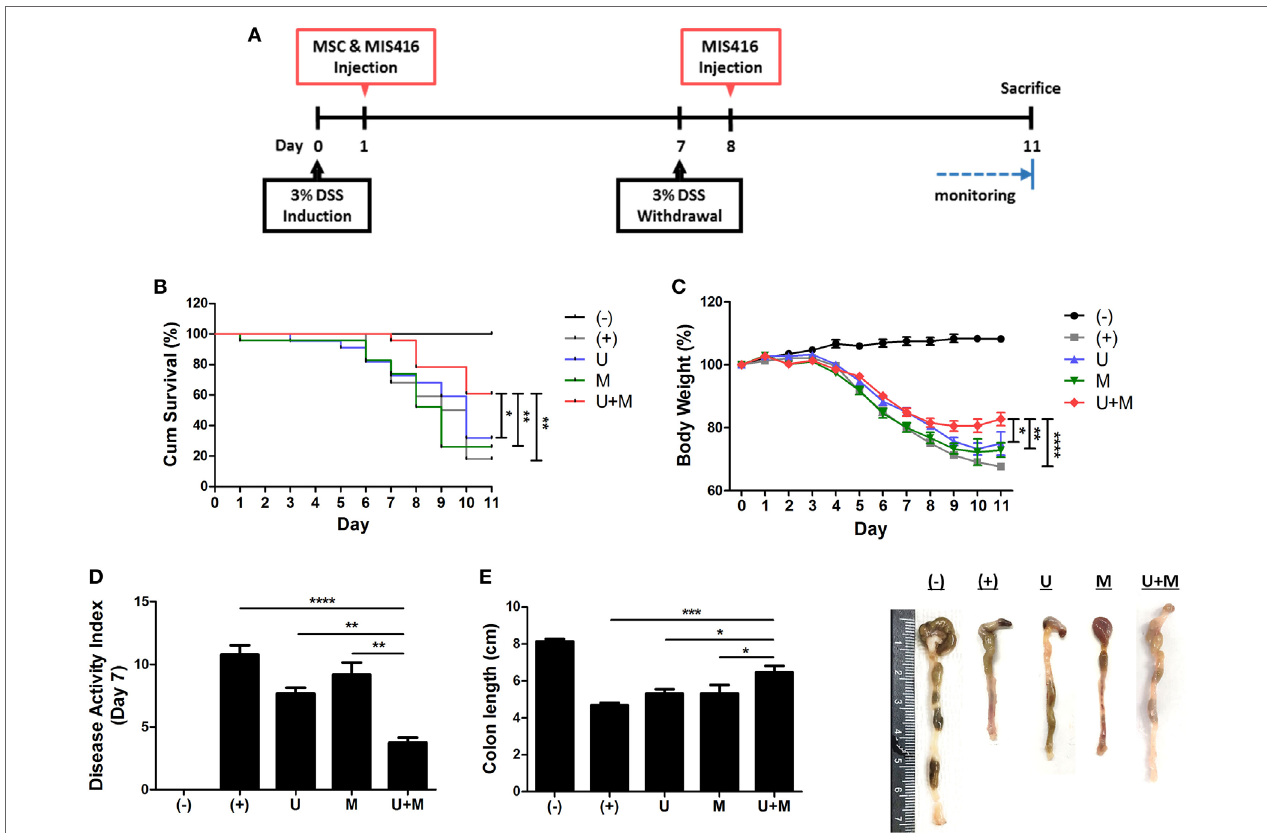
FigUre 1 | Simultaneous administration of MIS416 and human adult stem cells, including umbilical cord blood-derived mesenchymal stem cells (hUCB-MSCs) enhances therapeutic effects of the cells against experimental colitis. Mice were exposed to 3% dextran sulfate sodium (DSS) in their drinking water for 7 days and injected intraperitoneally hUCB-MSCs at day 1, and MIS416 at day 1 and 8 through retro-orbital route. (a) Scheme for the experimental design. (B) Survival rates of the mice were monitored. (c) Changes in body weights were measured daily. (D) Disease activity index for colitis severity. (e) On day 11, colon length of mice was measured by gross examination. n = 10–22 mice per group, three independent animal experiments were performed. ( − ): negative control group, ( + ): DSS administered group, U: hUCB-MSCs-treated group, M: MIS416-treated group, U + M: hUCB-MSCs and MIS416 co-treated group. * P < 0.05, ** P < 0.01, *** P < 0.001, and **** P < 0.0001. Results are shown as the mean ±